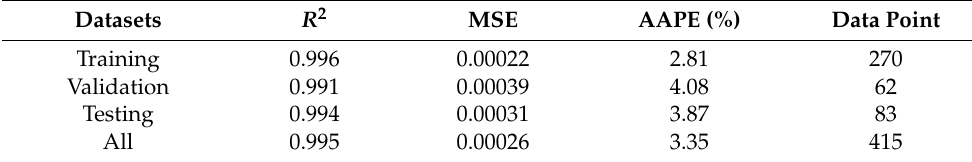
Table 3. Evaluation of the prediction performance of the ANN model developed.